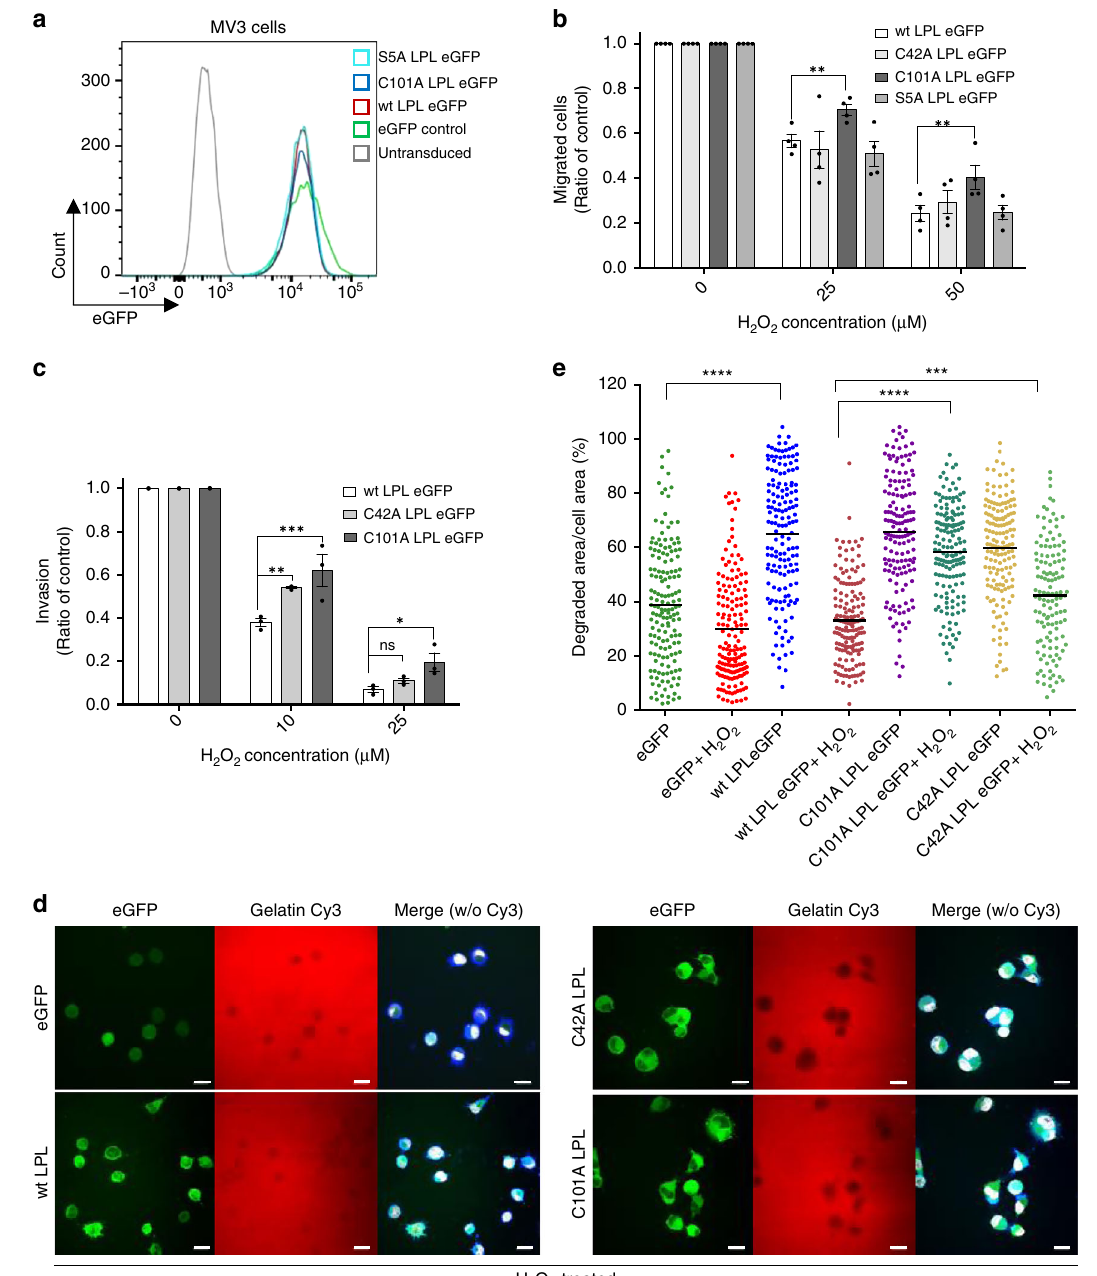
Fig. 7 The migration and ECM degradation capacities of MV3 cells. a Histograms showing stable expression of LPL eGFP in MV3 cells. MV3 cells were transduced with lentiviral vectors expressing the indicated LPL constructs. Cells with intermediate LPL eGFP expression were sorted using FACS. b Quanti fi cation of the migration of MV3 cells expressing the indicated LPL constructs in 2D Transwell chambers and c in 3D invasion chambers. A total of 3× 10 4 cells were added to the upper chamber. Thirty minutes later, the cells were treated with the indicated concentrations of H 2 O 2 . The samples were fi xed and mounted on microscopy slides. More than fi ve xy focal planes per sample were imaged using LSM (×20 objective). d Representative confocal microscopy images showing the matrix degradation capacity of MV3 cells expressing eGFP alone or eGFP-tagged wt LPL, C101A LPL, or C42A LPL constructs. The cells were allowed to degrade Cy3-gelatin for 3 h in the presence of 25 µ M H 2 O 2 . Shown are LPL eGFP (green), gelatin Cy3 (red) and merged images without (w/o) Cy3 (eGFP, F-actin (blue) and nuclei (white)). Scale bar = 20 μ m; ×60 magni fi cation. e Matrix degradation was quanti fi ed as the loss of fl uorescence underneath the cells versus the total area of the cells. At least 150 cells were imaged per sample from three independent experiments. P -values were calculated by two-way ANOVA. The data are presented as mean ±SEM ( n ≥ 3; * p <0.05, ** p < 0.01, *** p < 0.001, **** p <0.0001, ns nonsigni fi